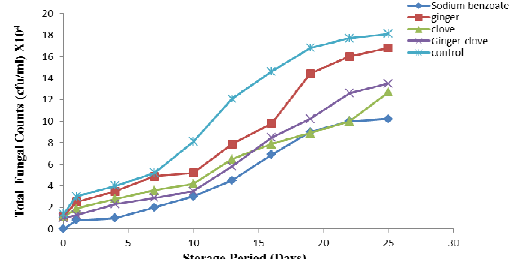
Fig. 3. Effects of different treatments on bacterial counts of soymilk samples at 5% concentration stored at refrigerated temperature for 25 days